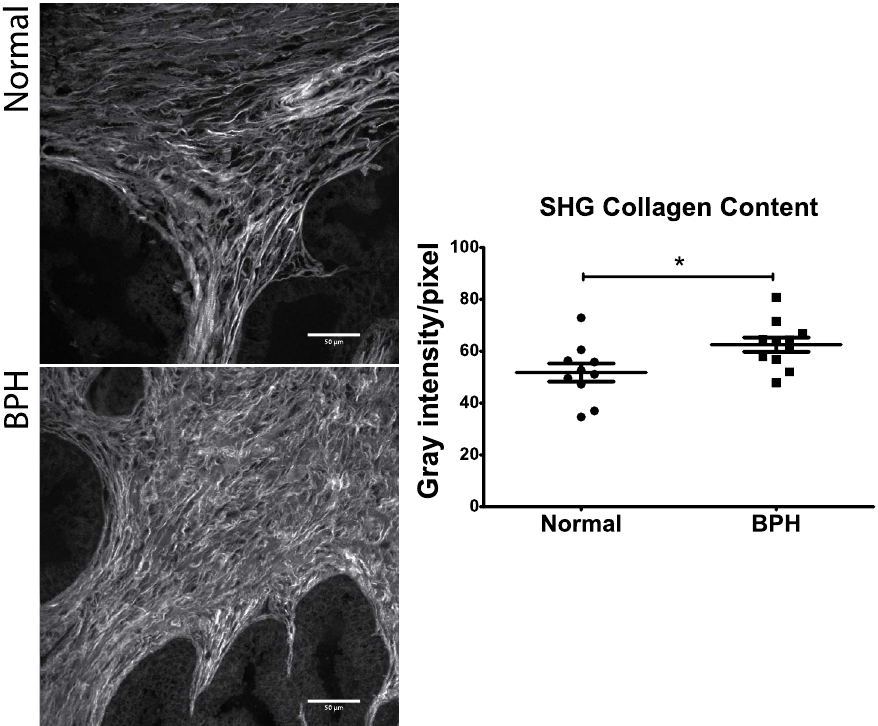
Figure 3. Evaluation of collagen content in normal prostate and glandular benign prostatic hyperplasia (BPH) with second harmonic generation (SHG) imaging. Using SHG imaging, a total of 12–15 optical sections were acquired (40x objective) per core from a subset of normal prostate tissue (n=10) and BPH (n=11). Optical sections were stacked and flattened to create maximum intensity Z-projections using Fiji software. Collagen content was quantified as the mean gray intensity within the region of interest. Using SHG imaging, a significant increase in collagen content was observed in BPH (mean=62.52, SEM=2.738) compared to normal prostate tissue (51.77 6 3.492; p=0.02).